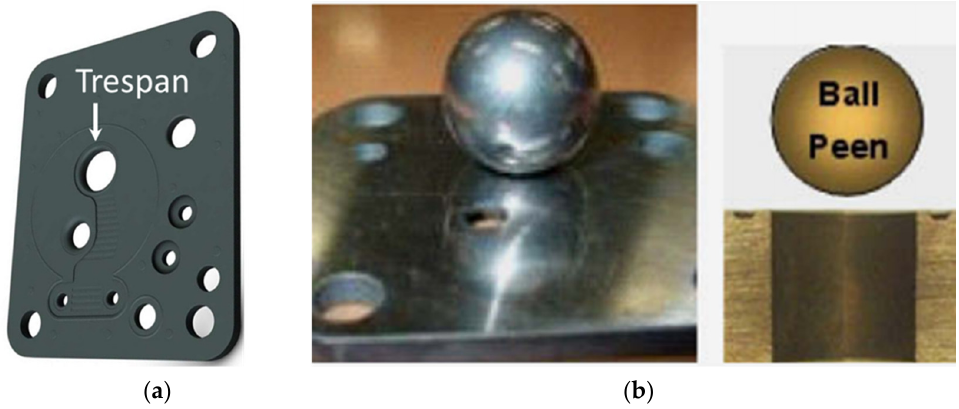
Figure 13. Redesigned valve plate: ( a ) trespan in valve plate; ( b ) ball peening process.